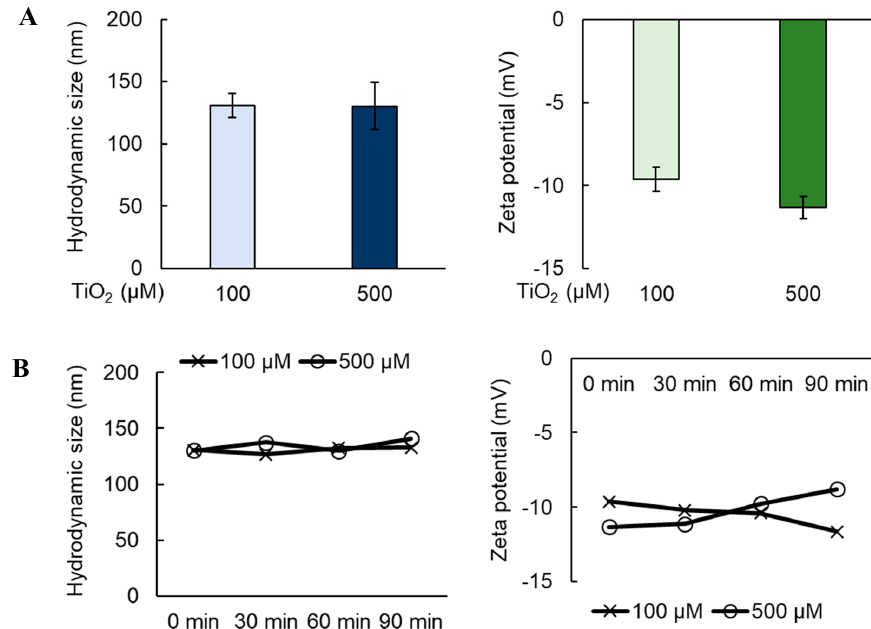
Figure 1. Characterization of titanium dioxide NPs (TiO 2 NPs) in media. ( A ) Hydrodynamic size (left panel) and surface zeta potential (right panel) of TiO 2 NPs in media at 0 min. Data represents mean ± SD, n = 3. ( B ) The stability of TiO 2 NPs was measured based on hydrodynamic size (left panel) and surface zeta potential (right panel) up to 90 min post-sonication. Data represents mean ± SD, n =